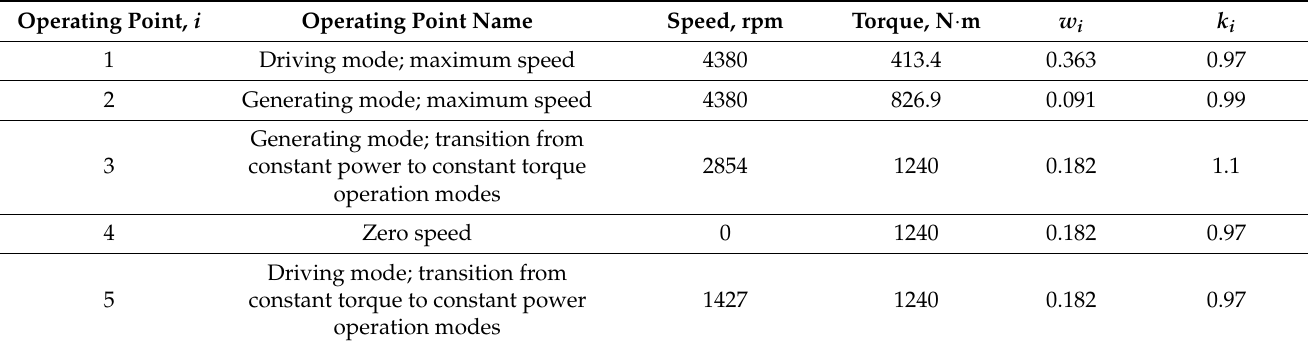
Table 1. Operating points of the traction motor considered during